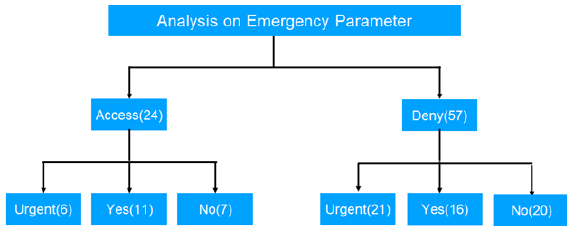
Figure 6. Analysis of Emergency